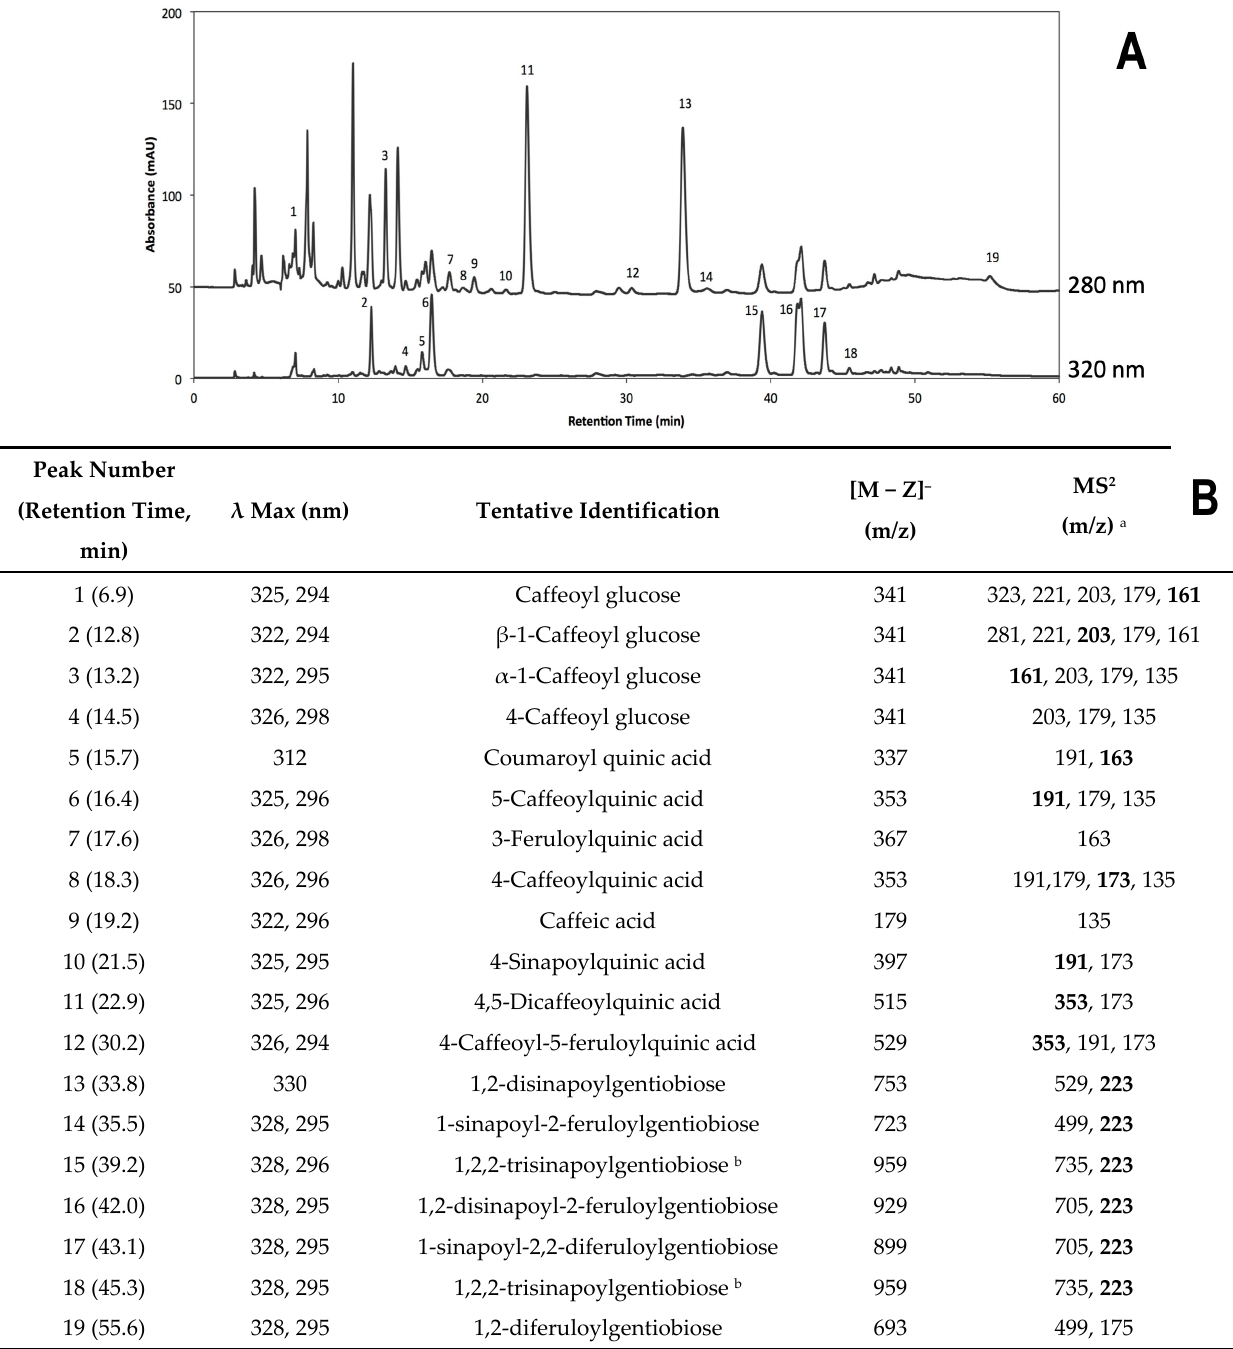
(Figure 3). The phenolic pro fi le identi fi ed in the present study is similar to that found in previous reports [4,29].